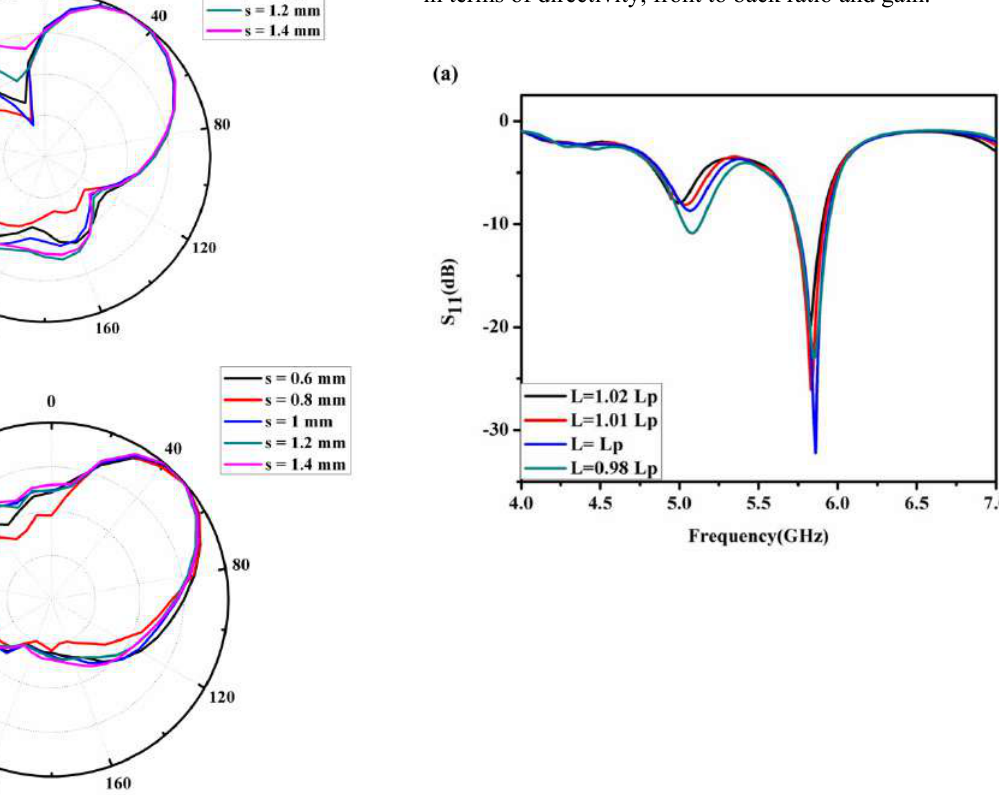
(a) S 11 , (b) E plane, and (c) H plane radiation pattern, for –34.5 dB with a different values of s . to 5.87 GHz. E-plane beam maximum remains 30˚ From H-plane pattern plot, it can be seen that beam tilt throughout the variation process of s , however side and angle is 40˚ for s = 1.4 mm, 1.2 mm while it is 50˚ for s = 1 back lobes decrease gradually for decremental change in s mm, 0.8 mm, 0.6 mm values. However, at s = 0.8 mm, and becomes minimum at s = 0.8 mm. For s = 0.6 mm, side proposed PRPA offers optimum front to back ratio and directivity. As tilt angle and directivity are the most desirable performance parameters in this antenna, hence s = 0.8 mm is considered as the optimal value. 2) EFFECT OF PARASITIC ELEMENT LENGTH The effect of parasitic element length L on reflection coefficient and beam tilt angle are also investigated by changing L as 1.02 × L P , 1.01 × L P , L P and 0.98 × L P . As shown in the Fig. 5, simulated S 11 values are –20.1 dB (5.81 GHz), –26 dB (5.83 GHz), –32.2 dB (5.86 GHz) and – 23.02 dB (5.84 GHz) for L = 1.02 × L P , 1.01 × L P , L P and 0.98 × L P respectively. From E-plane radiation pattern plot, it can be seen that direction of beam maximum is at 40˚ for L = 1.02 × L P , and remains constant at 30˚ for L = 1.01 × L P , L P and 0.98 × L P . Again, beam tilt angle is obtained as 50˚ in H-plane for all L values used in the parametric study. However, L = 1.01 × L P is considered as the optimal parasitic length because of superior radiation characteristics in terms of directivity, front to back ratio and